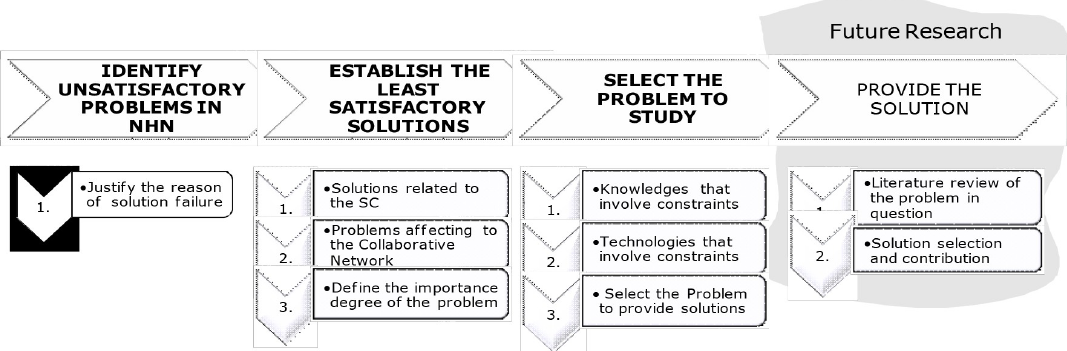
Figure 1. Methodology for selecting relevant problems in